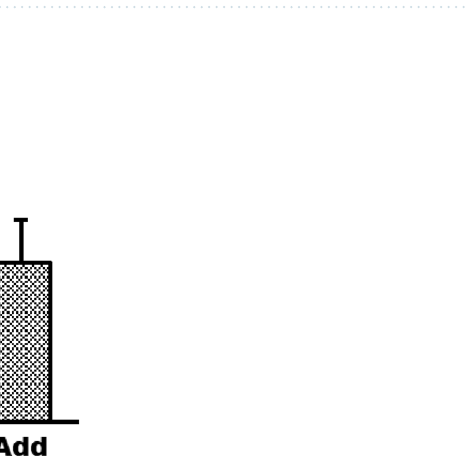
Figure 7. Average ± SD of conditioned MEP (% test pulse alone) from the FDI muscle during ME of abduction (abd), adduction (add), and rest phases. ( * p <